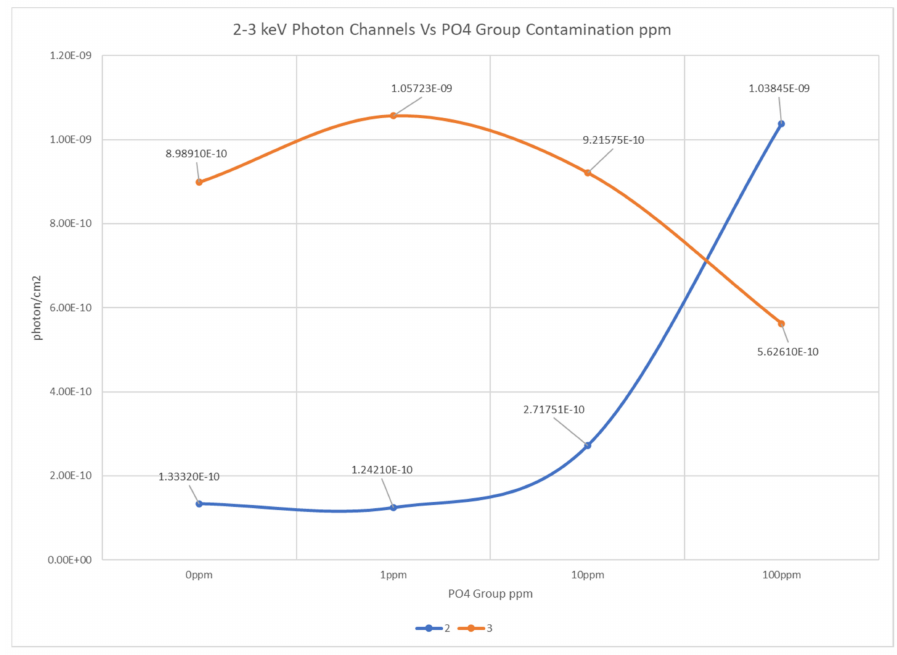
Figure 13. Photon channel 2–3 keV vs.